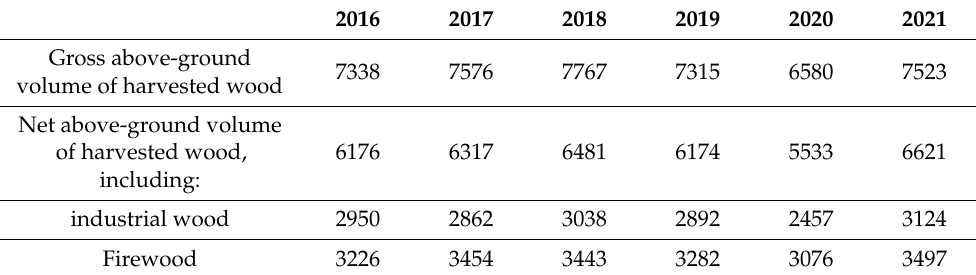
Table 1. Total wood harvest in Hungary between 2016 and 2021 (thousand m 3 )